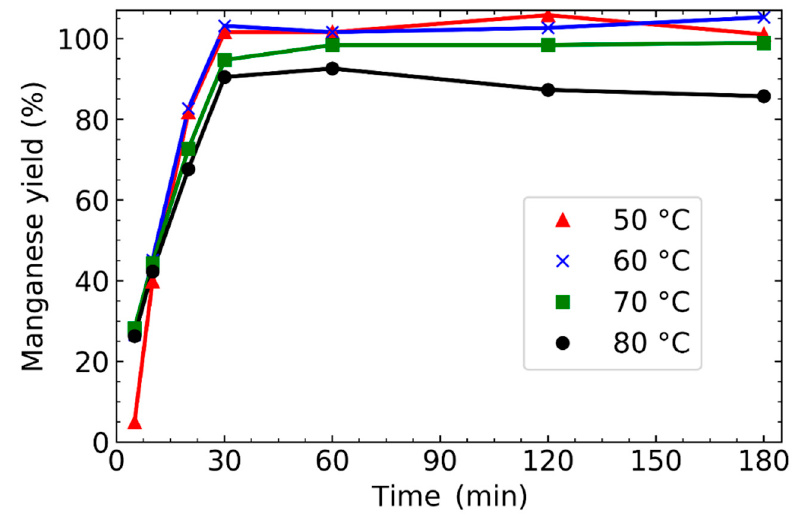
Figure 5. Manganese yield as a function of time at 50, 60, 70 and 80 ◦ C (S / L ratio 420 g / L, H 2 O 2 ).